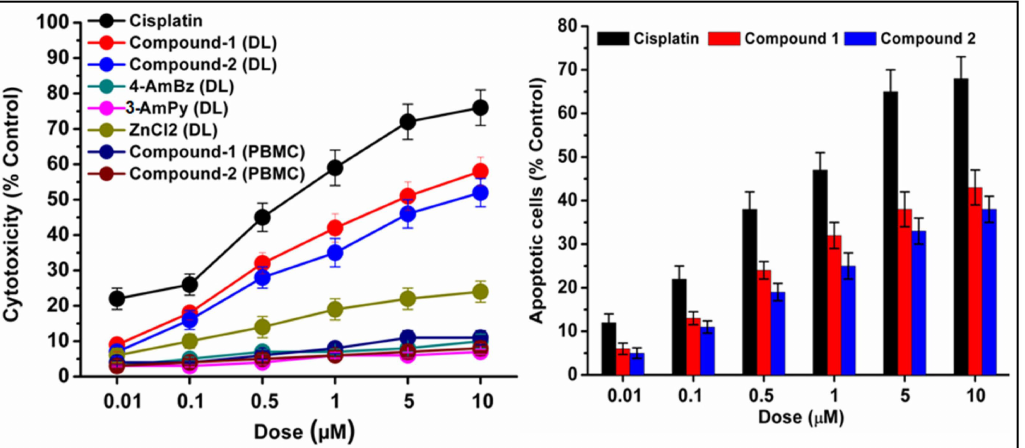
Figure 13. Concentration-dependent cytotoxicity (left) induced by compounds 1 and 2 in DL cells. The results of the compounds were compared with cisplatin (reference drug). Percentage apoptotic cells (right) in DL cell line after exposure to compounds 1 and 2 . Data are mean ± S.D., n =